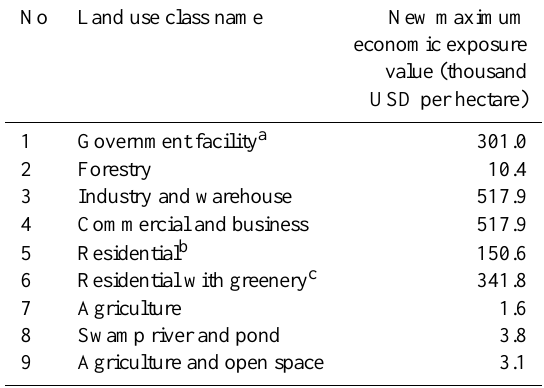
Table 3. Maximum economic exposure values per land use class for land use map 2030, using an exchange rate of USD1 =